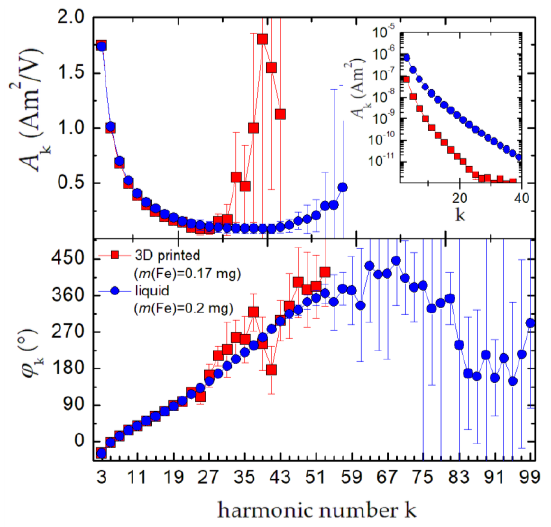
Figure 3. Transfer function of the benchtop MPS detector as determined by two different magnetic nanoparticle (MNP) systems: A robust and long-term stable 3D printed cylinder of EFH (red squares) and liquid suspension of FER (blue circles). Note, the connecting lines are a guide to the eye.